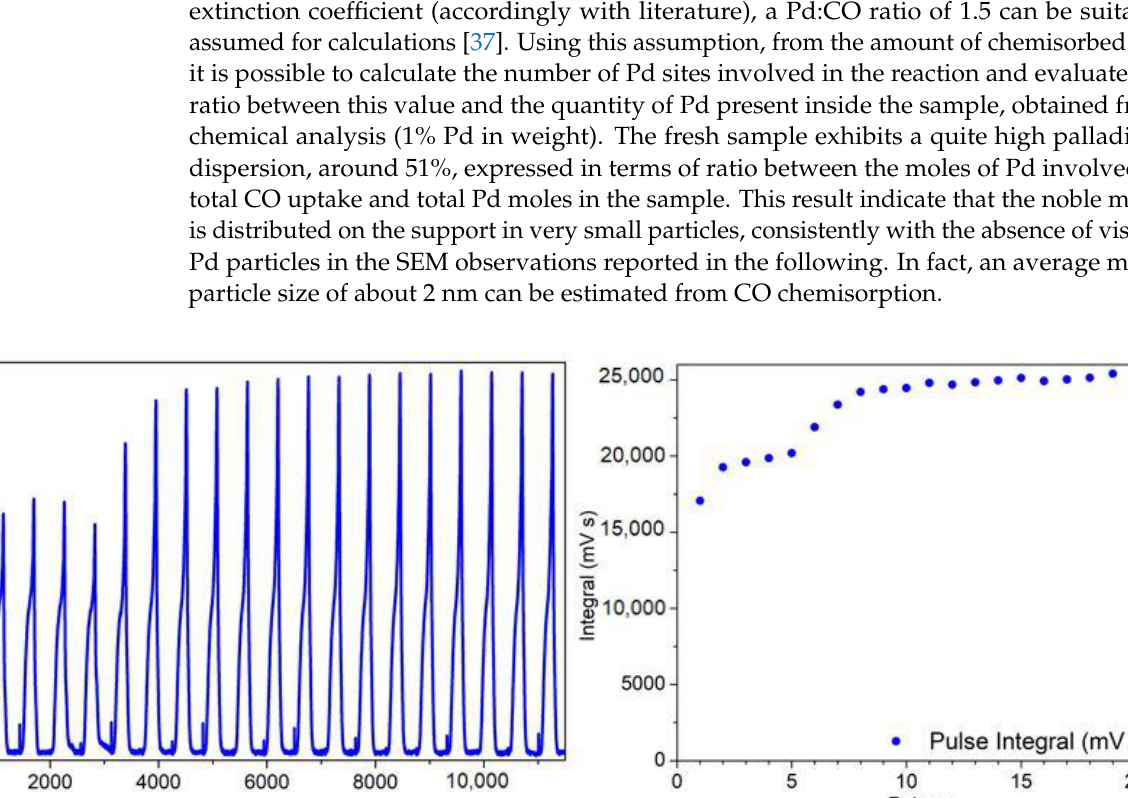
Figure 5. 25,000 km sample : integrals of TCD signal peaks registered during successive manual dosage of pulses of 800 µL of 10% CO in He carrier, until saturation. The dispersion of Pd in this sample is decreased to 8%, and for the 60,000 km catalyst, it is below 1%, although in the latter cases the CO uptake is too low to obtain reliable values. These results point out that the metal particles are sensitive to sintering during the catalyst life cycle, as suggested by FT-IR measurement. The CO chemisorption test was performed also on laboratory-aged sample, in order to verify the correlation with 60,000